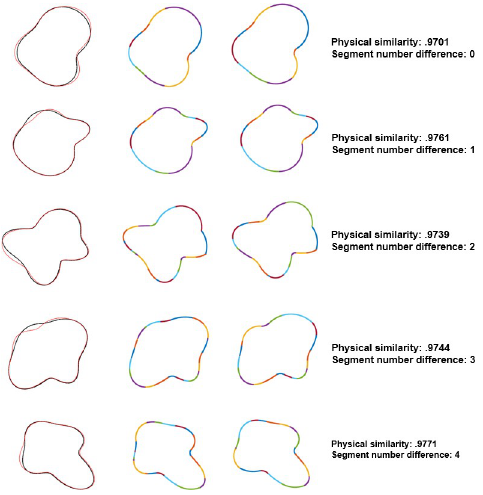
Fig 12. Sample shape pairs from the five experimental conditions in Experiment 3. In the left column, we show the two shapes overlaid on top of each other (Shape 1 in black, Shape 2 in red) to show the physical differences between the two contours. In the middle column, we show the constant curvature representation of Shape 1. In the right column, we show the constant curvature representation of Shape 2. Physical similarity refers to the physical contour difference between the two shapes, as measured by the overlap of their interiors. Segment number difference refers to the difference in the number of constant curvature segments between the two shapes using the parameterized constant curvature model.